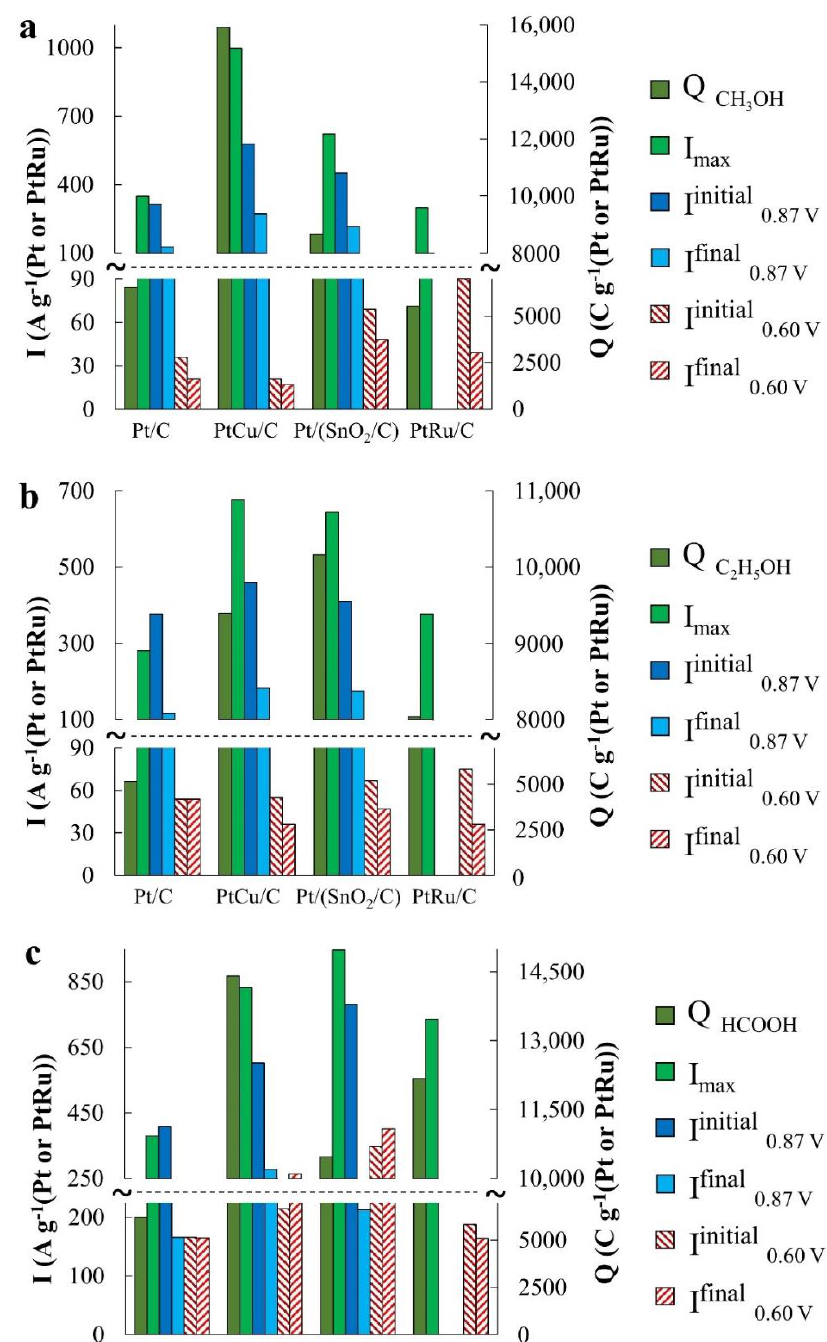
Figure 5. ( a )—Cyclic voltammograms, ( b , c )—chronoamperograms at a potential of 0.87 V ( b ) and 0.60 V ( c ). Electrolyte—0.1 M HClO 4 solution with the addition of 0.5 M CH 3 OH, saturated with Ar at atmospheric pressure.